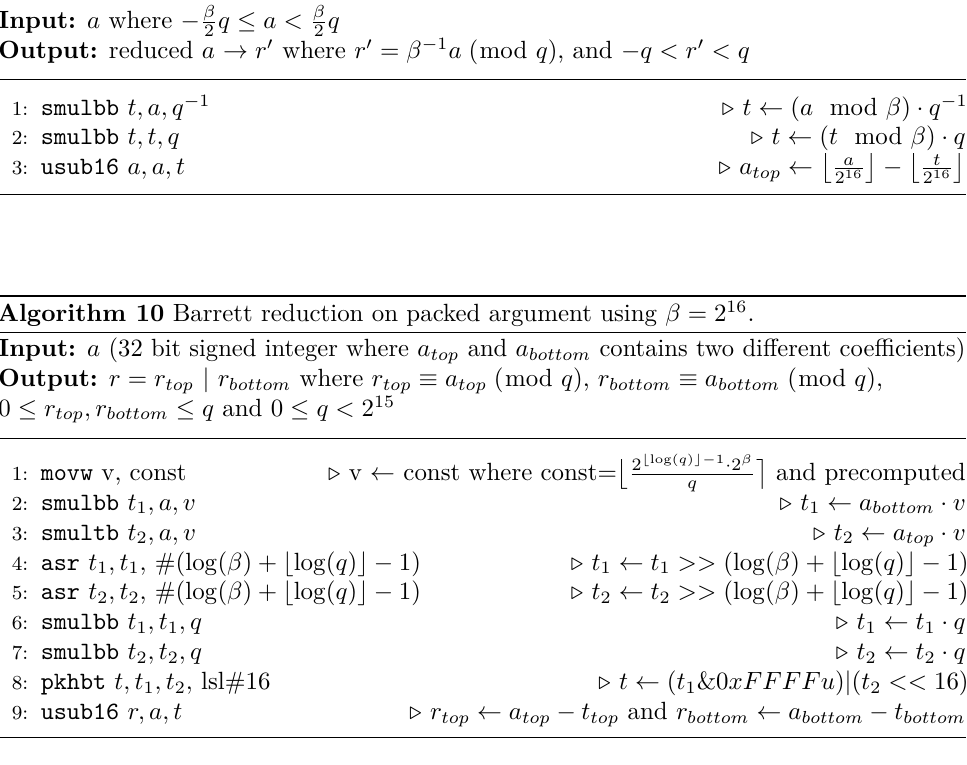
Algorithm 9 Signed Montgomery reduction [BKS19] using Montgomery factor β = 2 16 .